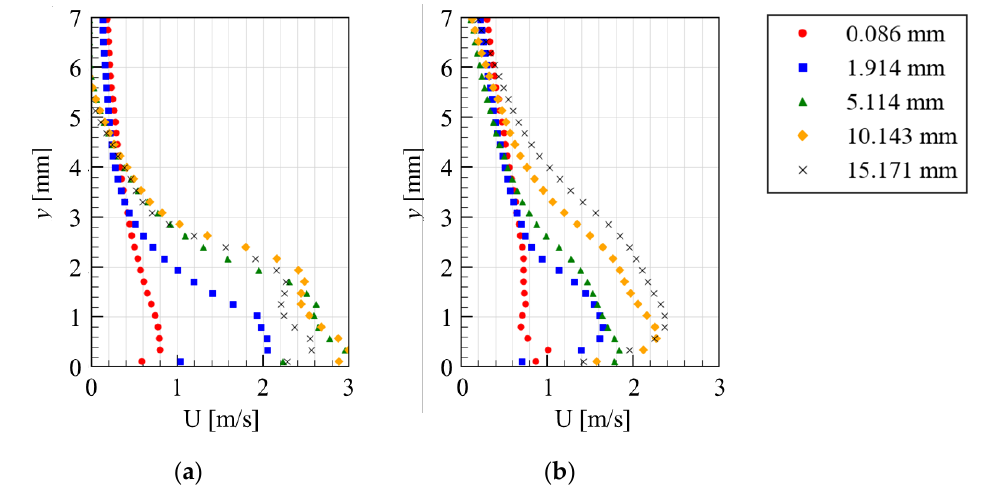
Figure 19. y -profiles of the horizontal velocity of ( a ) the plate-PA and ( b ) the wire-PA. Next, the horizontal thrusts, F x , generated by the PAs, are discussed. The thrust is numerically calculated on the basis of momentum conservation in a control volume